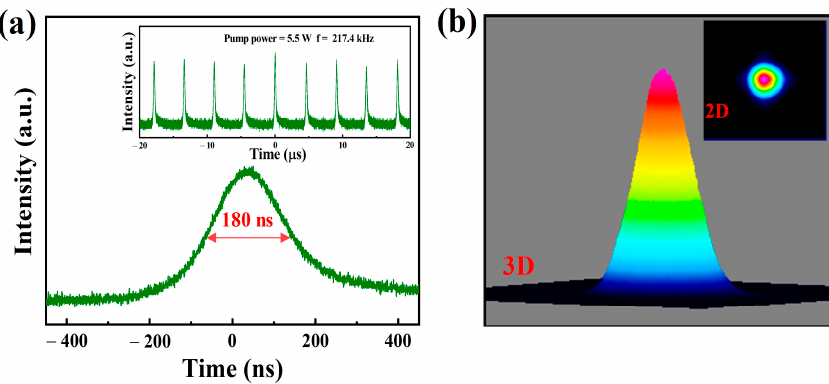
Figure 6. ( a ) Stable pulse train at the highest repetition rate and shortest pulse profile and ( b ) 2D, 3D beam profiles of the PQS Nd: YAG laser at the highest pump power (5.5 W). In laser application, short pulse width and high optical efficiency are both important to a PQS bulk laser [43]. Table 1 summarizes the laser performances of PQS solid-state lasers with different new 2D material-SAs. The corresponding data (pulse width versus repetition rate) are shown in Figure 7; the different marks represent different new 2D materials. Compared with the Ta 2 NiS 5 -SA applied in 1.9 µ m PQS bulk laser [30], the 1 µ m PQS bulk laser based on Ta 2 NiS 5 -SA in this letter shows a shorter pulse width (approximately 57.5%). The different optical efficiency may be due to the different linear absorption (1.9 µ m: ~19%, 1.0 µ m: ~27.4%) and nonlinear absorption properties (1.9 µ m: ∆ T = 12.2%, I 2 , NL = 6.9%, 1.0 µ m: ∆ T = 7.3%, I 2 , sat = ~5.1 MW/cm sat = ~0.32 GW/cm NL = 11.6%) of Ta 2 NiS 5 materials in 1.9 µ m [30] and 1 µ m. But compared with new 2D